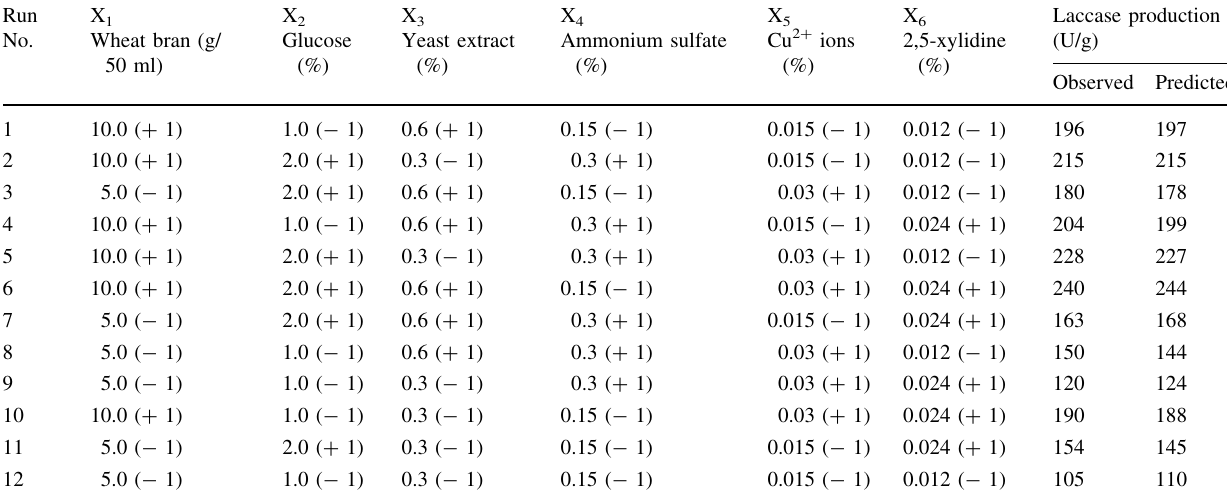
Table 1 PBD matrix for the screening of independent variables with actual and coded values affecting laccase production Run No.